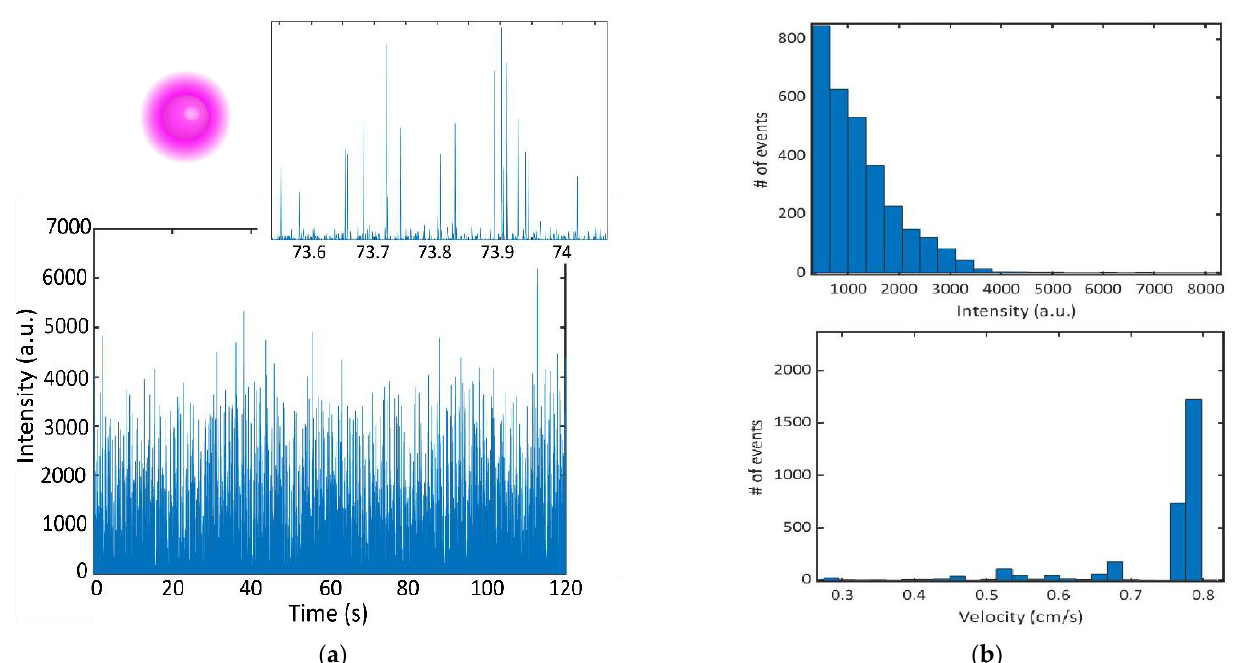
Figure 4. ( a ) Fluorescence time domain trace illustrating peaks observed from 4 × 10 7 beads/mL 1 um fluorescent microspheres with an absorption maximum at 580 nm and emission maximum at 605 nm. Inset image shows a zoomed in window to illustrate individual events. ( b ) Intensity histogram of detected fluorescent events (top). The average intensity of events is 1222 with a standard deviation of 894. Velocity histogram of detected events (bottom). The average velocity of beads is 0.74 cm/s with a standard deviation of 0.01 cm/s.